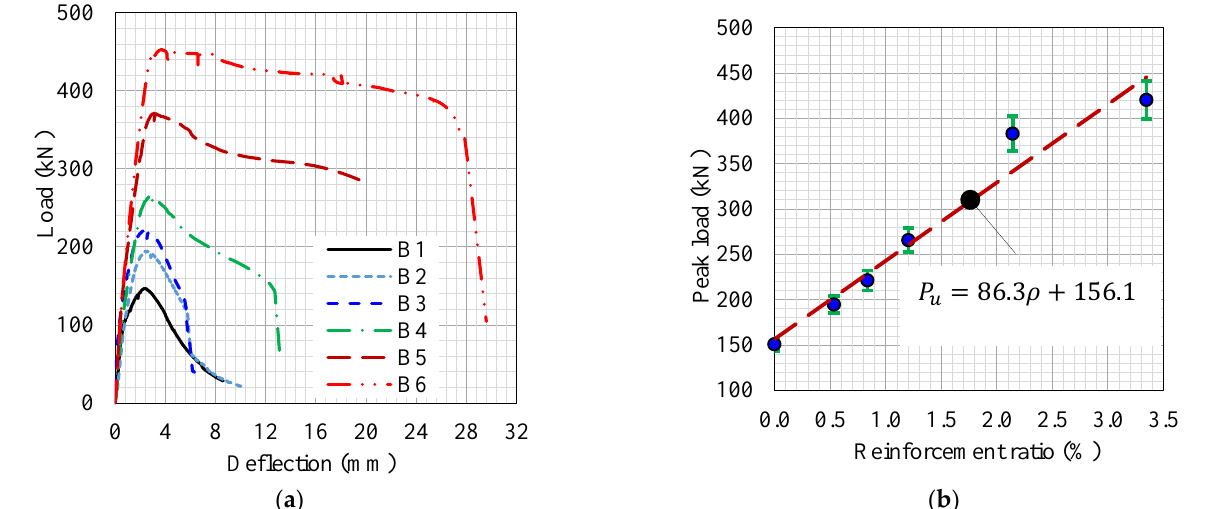
Figure 8. ( a ) Load – deflection of beams and ( b ) peak load-reinforcement ratio relation.